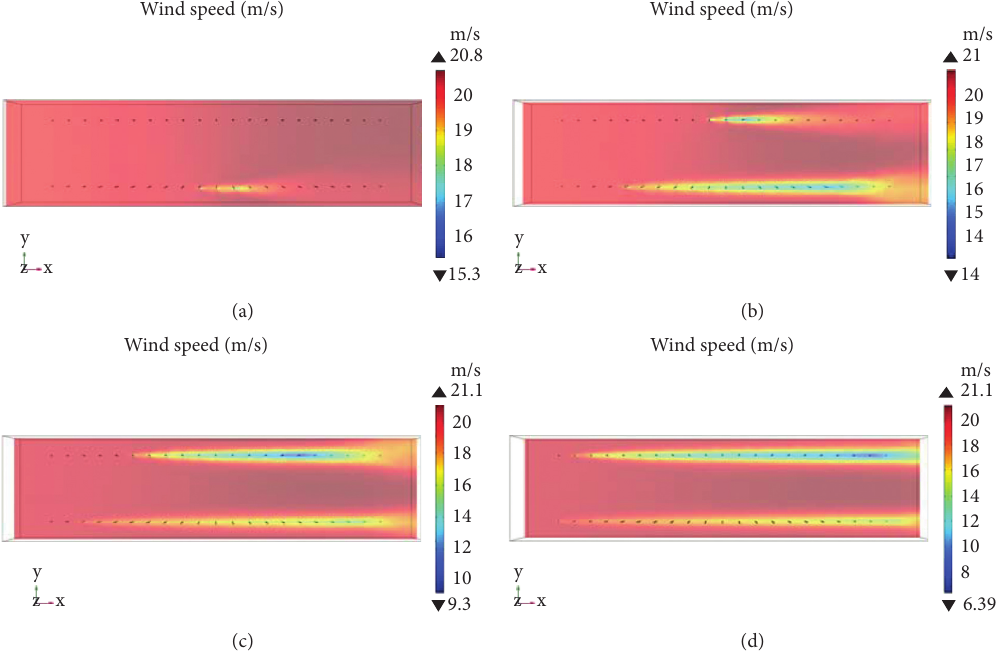
Figure 3: Influence of height for wind field (wind direction � 0 ° /180 ° ). (a) 0 ° /180 ° , z � 10m. (b) 0 ° /180 ° , z � 5m. (c) 0 ° /180 ° , z � 3m. (d) 0 ° / 180 ° , z �